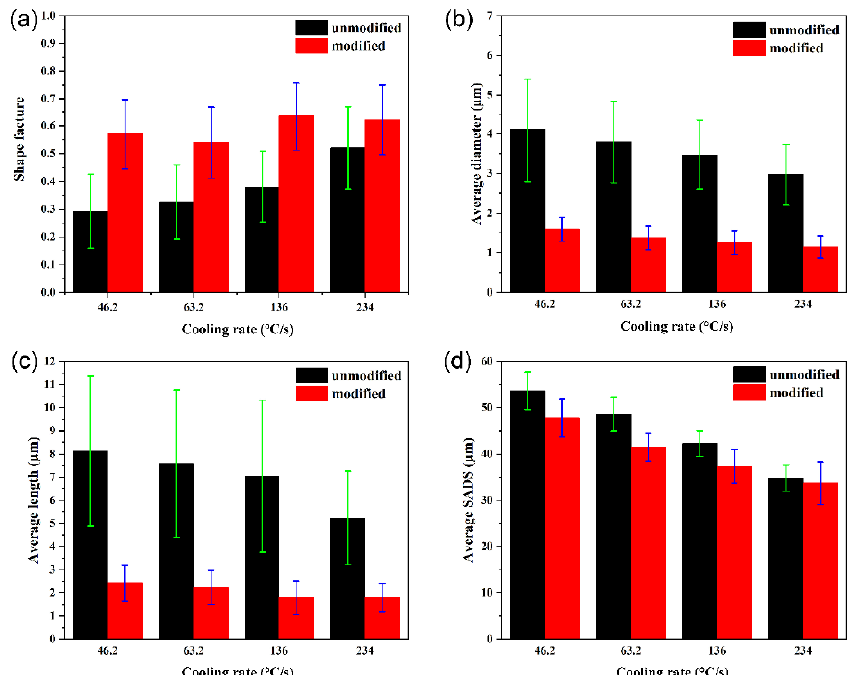
Figure 3. Eutectic silicon particles ( a – c ) and α -Al ( d ) (with and without Sr) under different cooling rates: ( a ) average shape facture, ( b ) average diameter, ( c ) average length, ( d ) average SDAS.